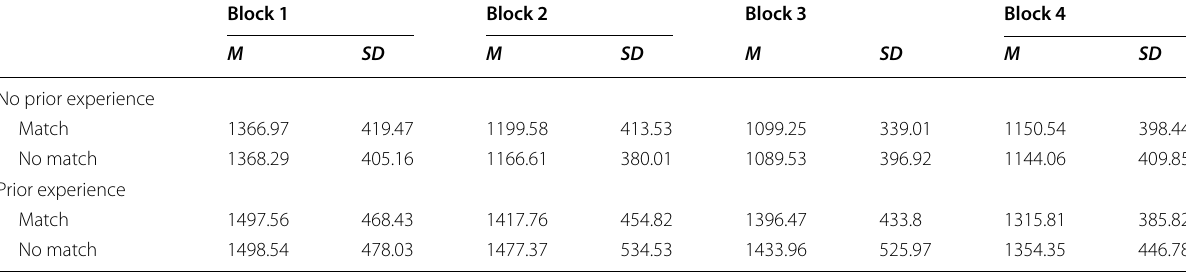
Table 2 Ongoing task response time across blocks by experience condition in Experiment 1